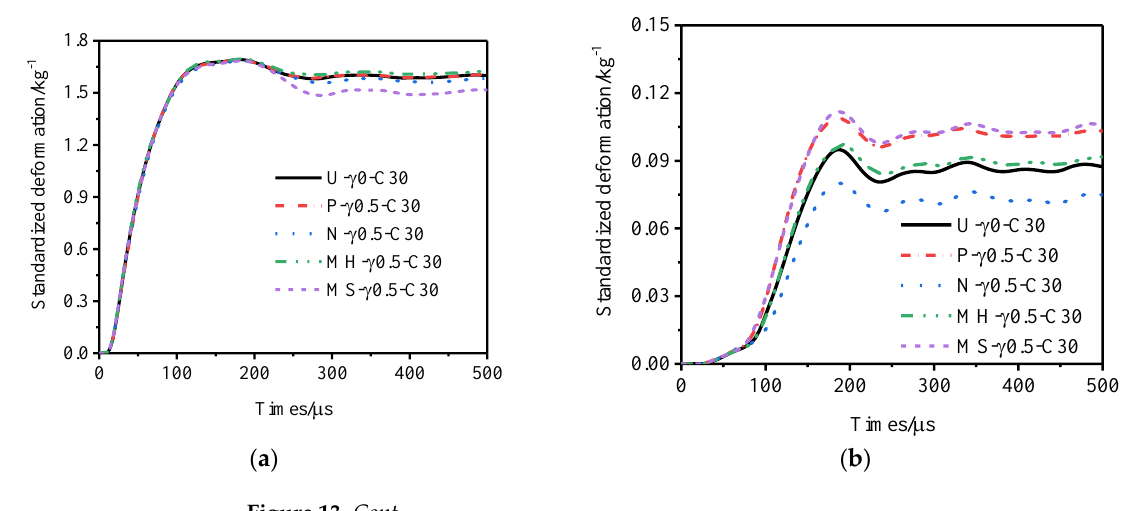
Figure 12. Anti − explosion performance of a foamed aluminum sandwich tube when the core density gradient is 1.0. ( a ) Deformation curve of the inner tube, ( b ) deformation curve of the outer tube, ( c ) total energy absorption of the sandwich tube, and ( d ) specific energy absorption of the sandwich tube.